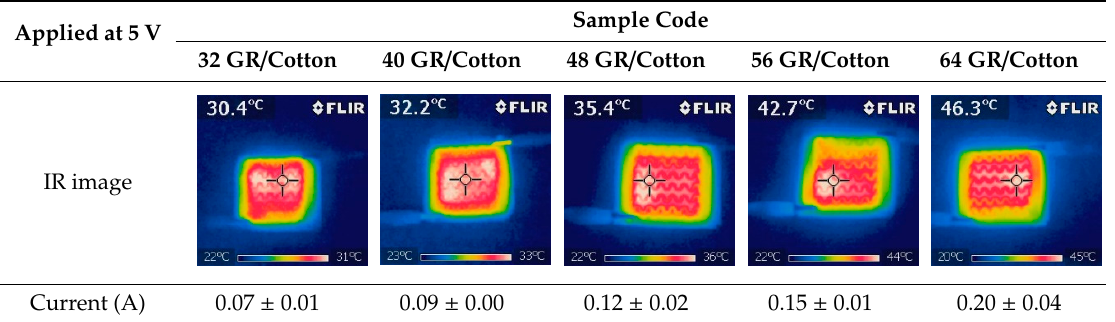
Figure 7. Variation of surface temperature of GR/cotton coated with various high-content of graphene nanoplatelets.